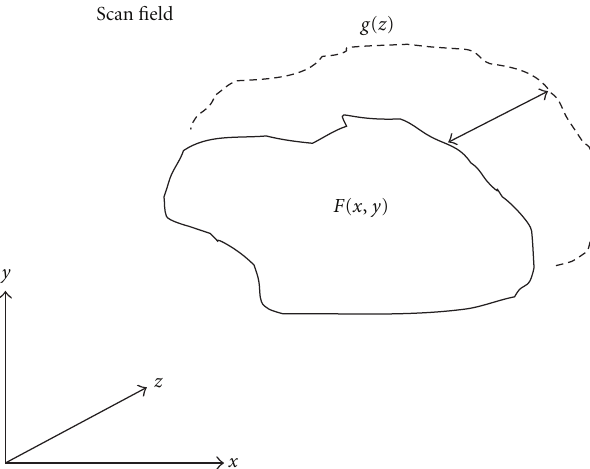
Figure 6: Scan results of various thicknesses simulated pneumoth- oraces.